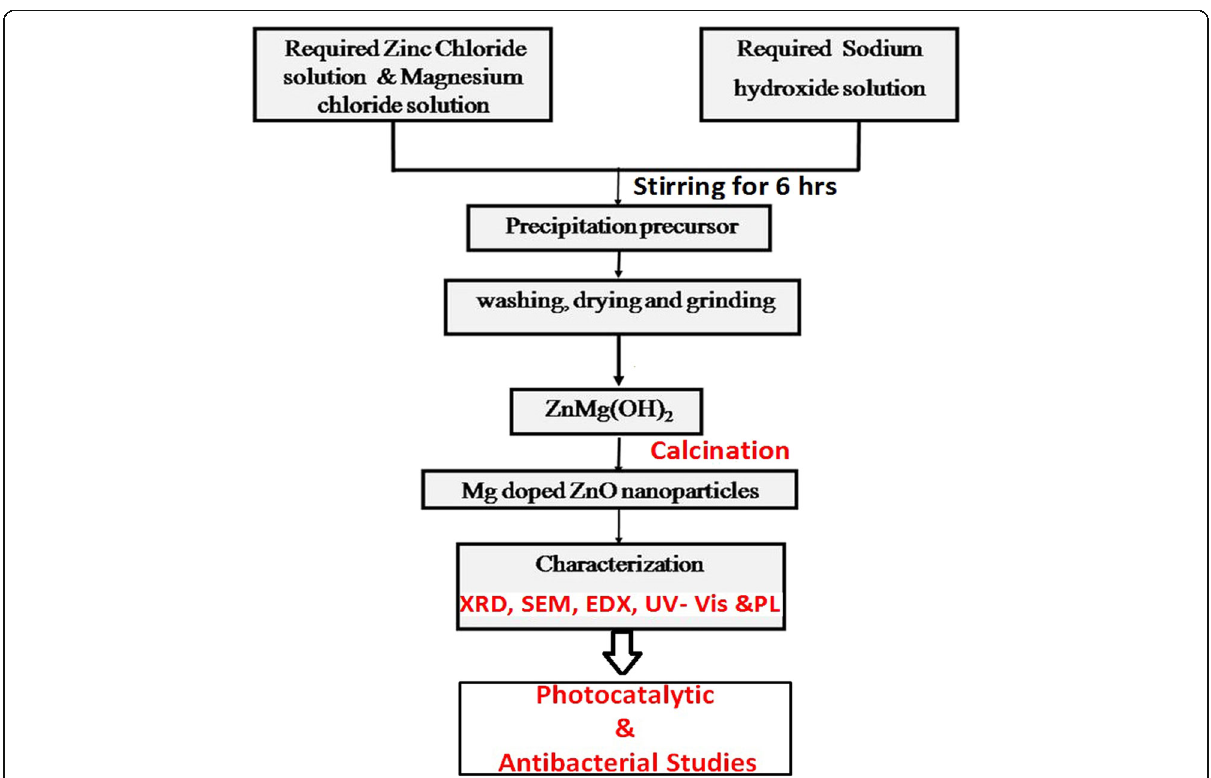
Fig. 1 Flow chart describing the synthesis of Mg-doped ZnO